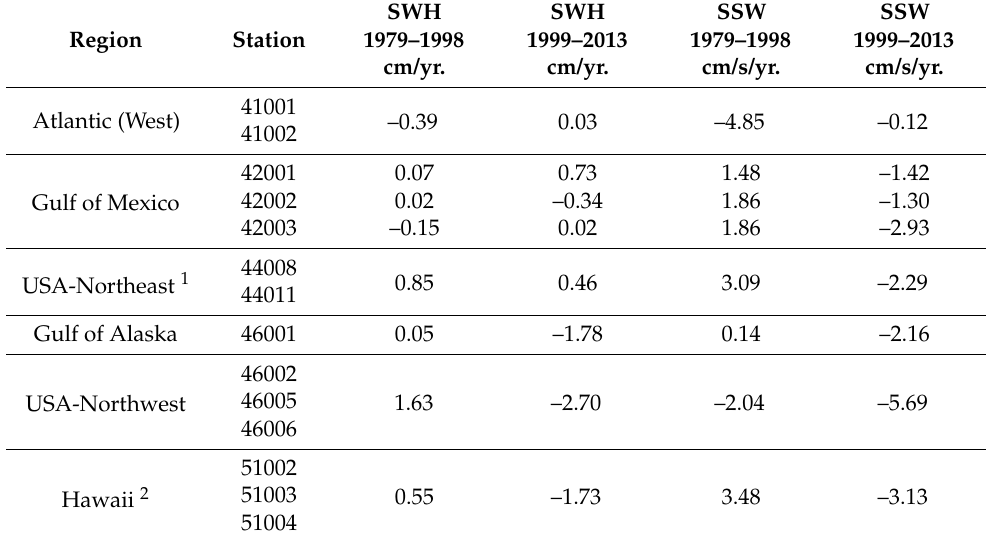
Table 1. Trend estimates for the annual mean SWH and SSW at buoy locations from NDBC data. Region Station